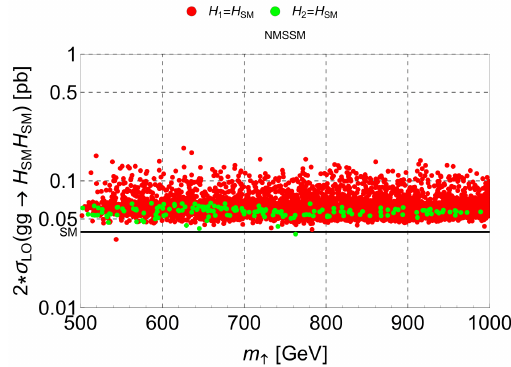
Figure 8 . Same as figure 7, but for the